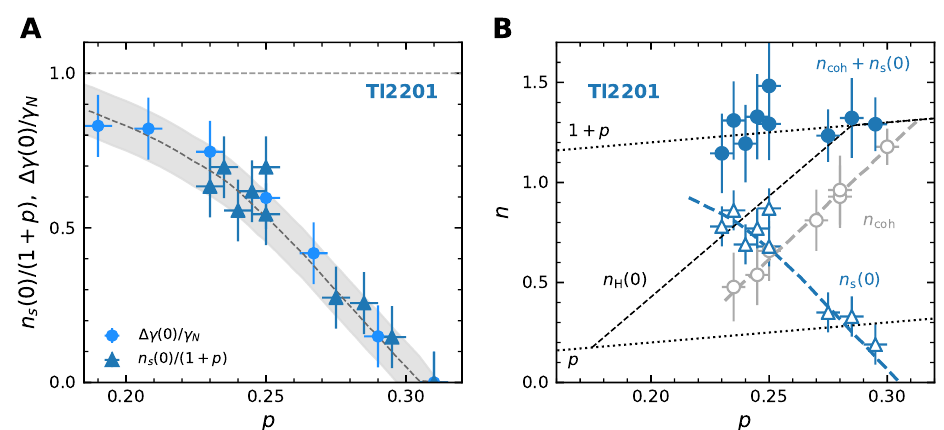
Figure 1: Superfluid density and coherent normal-state carrier density in over- ( 0 ) / ( 1 + p ) and ∆ γ ( 0 ) / γ doped Tl2201. A) Comparison of n in OD Tl2201, where s N ( 0 ) / ( 1 + p ) (triangles) is the fraction of the total Luttinger count (1 + p ) that con- n s ( 0 ) [ 4–6,35 ] and ∆ γ ( 0 ) / γ tributes to the as-measured superfluid density n (circles) s N is the fractional change in the electronic specific heat coefficient in the superconduct- ing state ∆ γ ( 0 ) relative to its value γ in the normal state [ 28,36 ] (see appendix A.7 N ( 0 ) is determined from 1 /λ 2 ( 0 ) using Eq. (2) with m ∗ = 5.2 m for details). n , con- s e ab sistent with γ for OD Tl2201 across the doping series [ 28 ] (see appendix A.6 for N details). The grey shaded region and dashed lines are guides to the eye. B) Open triangles: absolute n (0) values (per Cu) transposed from Panel A. Black dashed line: s ( 0 ) line for Tl2201 (again normalised to a single Cu site) derived from schematic n H high-field Hall effect measurements [ 14 ] . Open circles: corresponding n values coh ( 0 ) by the ratio (per Cu) for Tl2201, obtained by renormalising the as-measured n H (squared) of the coherent contribution to the total conductivity at 0 K, as determined ( T ) (see appendix A.1-3 for details). The faint dashed line is a fit by analysis of ρ ab + n ( 0 ) for Tl2201. For each through the data points. Blue filled circles: The sum n coh s ( 0 ) , the corresponding value of n value of n was read off from the faint dashed s coh line. The two thin dotted lines represent the relation n = p and n = 1 + p . Estimates of the error bars for each set of data are described in detail in the